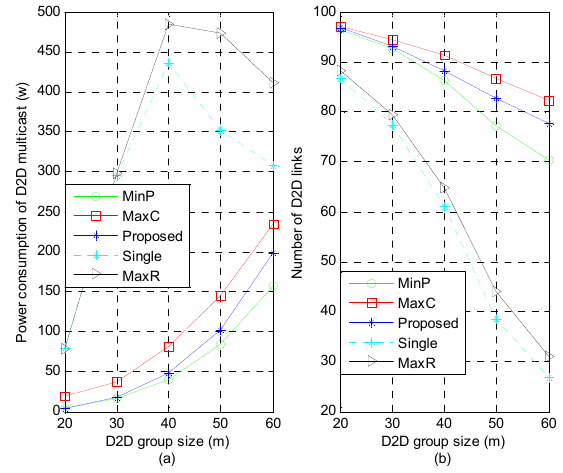
Figure 3. Power consumption and number of D2D links versus D2D group size: ( a ) Impact of D2D group size on power consumption; ( b ) Impact of D2D group size on system capacity.